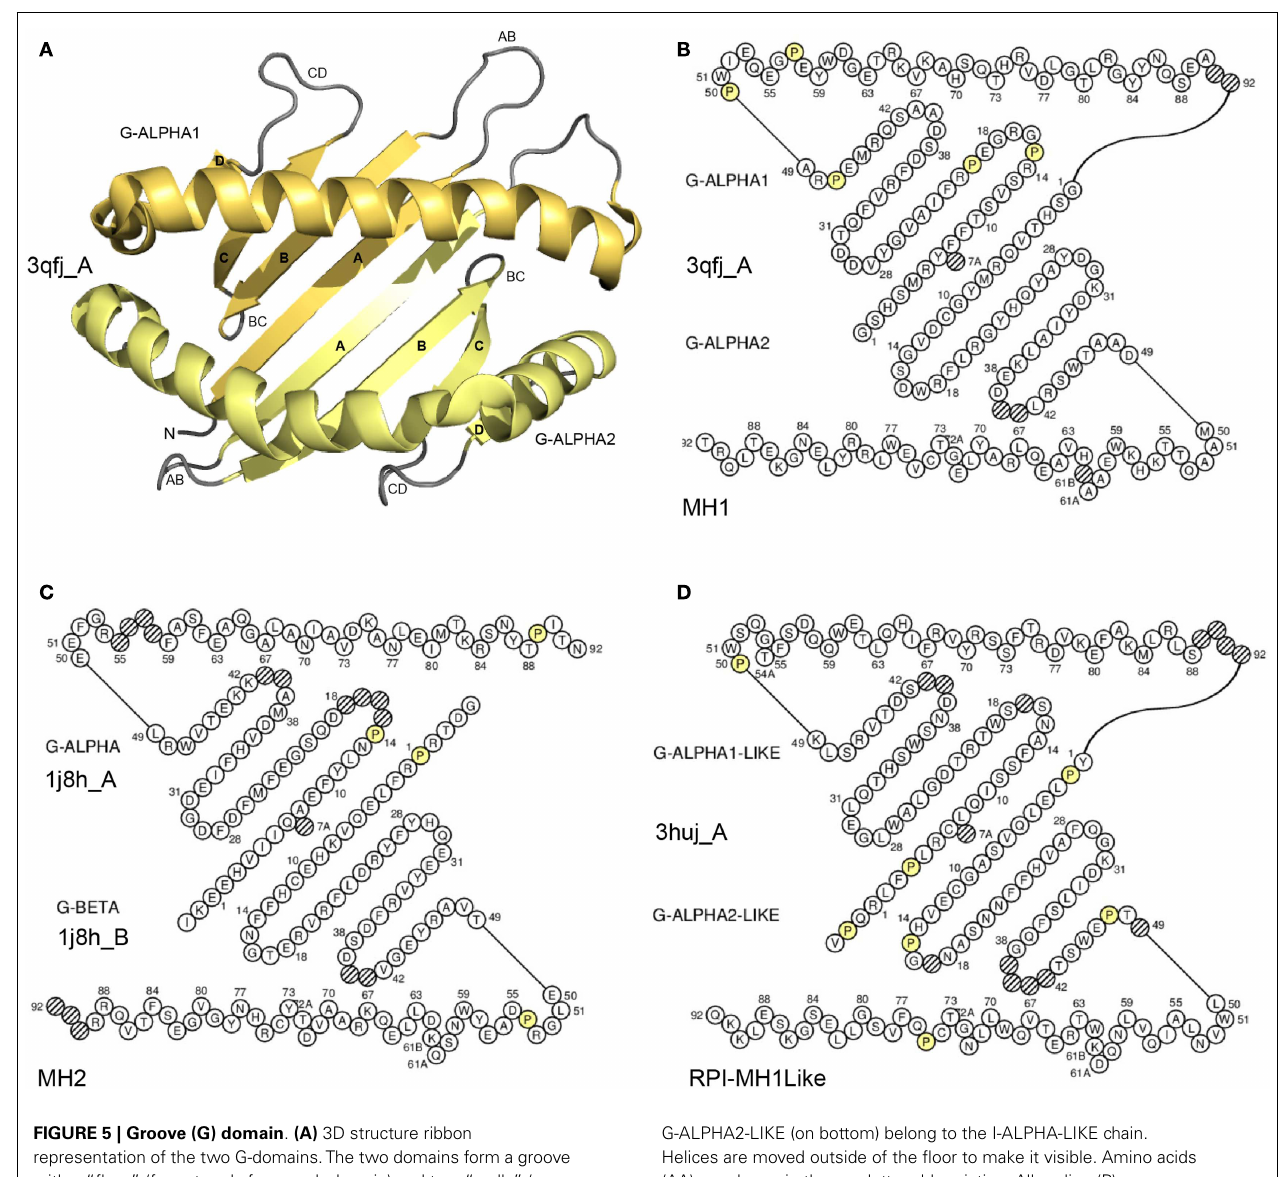
FIGURE 5 | Groove (G) domain . (A) 3D structure ribbon representation of the two G-domains.The two domains form a groove with a “floor” (four strands from each domain) and two “walls” (one helix from each domain) (8).The G-domains characterize the proteins of the MhSF, which comprises the MH (MH1 and MH2) and the RPI-MH1Like (MhSF other than MH) (8).The two G-DOMAIN of an MH1 are shown as an example.The view is from above the cleft with the G-ALPHA1 (on top) and G-ALPHA2 (on bottom). (B) IMGT Colliers de Perles of the two G-DOMAIN of an MH1. G-ALPHA1 (on top) and G-ALPHA2 (on bottom) belong to the I-ALPHA chain (8). (C) IMGT Colliers de Perles of the two G-DOMAIN of an MH2. G-ALPHA (on top) and G-BETA (on bottom) to the II-ALPHA chain and to the II-BETA chain, respectively (8). (D) IMGT Colliers de Perles of the two G-LIKE-DOMAIN of a RPI-MH1Like. G-ALPHA1-LIKE (on top) and